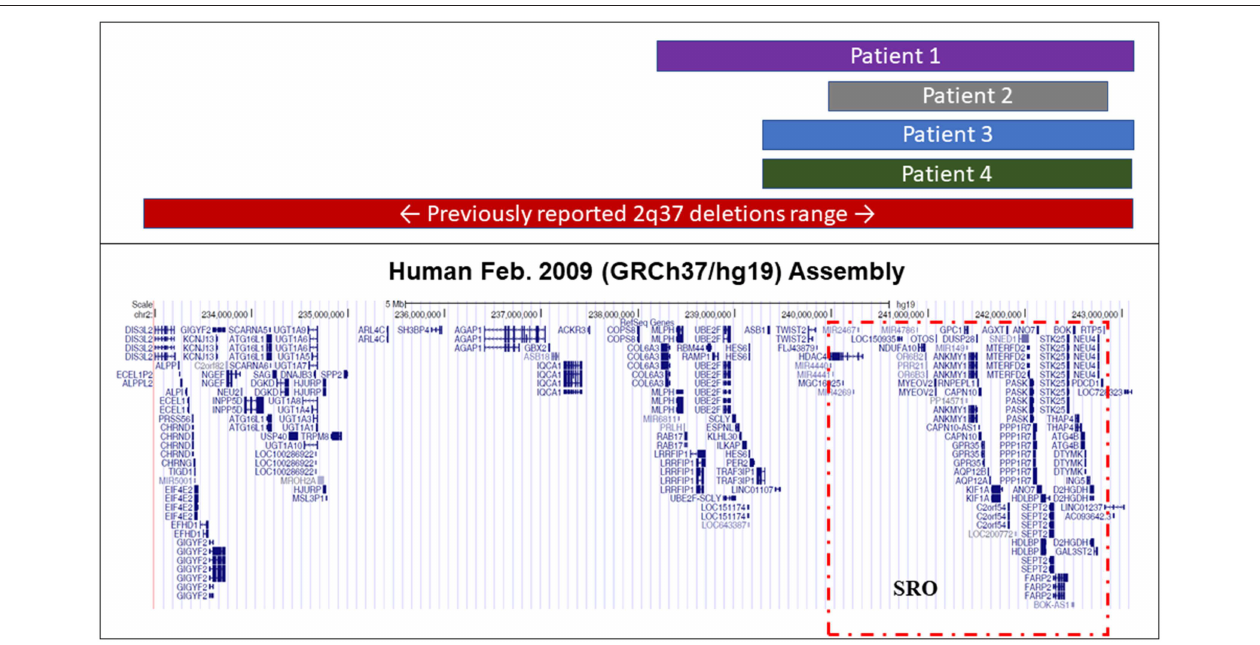
FIGURE 1 | Extension of known 2q37 deletions. Representative figure from the UCSC Genome Browser summarizing the extension range of previously reported BDMR-associated and novel deletions found in our iPPSDx patients. The smallest region of overlap (SRO) among our deletions, corresponding to the one discovered in patient 2, is highlighted in